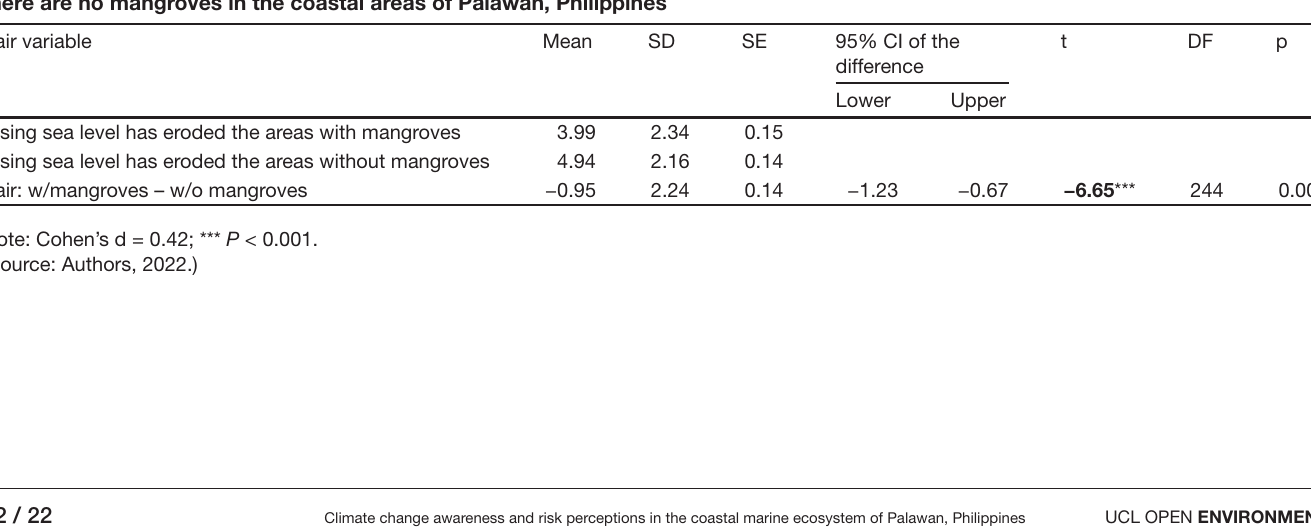
Shellfish farms